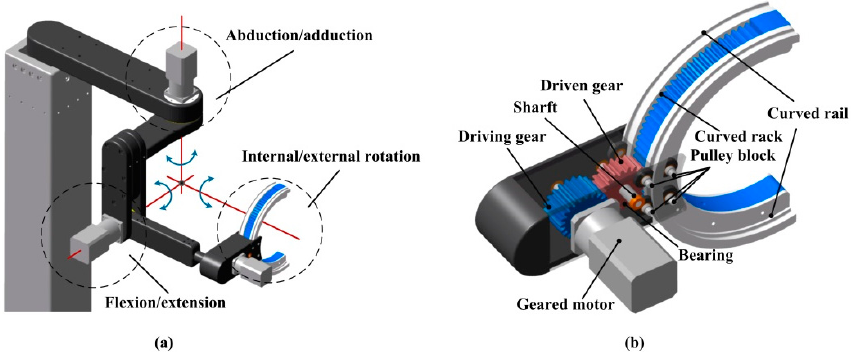
Figure 2. The structure diagram of shoulder joint. ( a ) Three-dimensional (3D) model of shoulder joint; ( b ) 3D model of shoulder joint rotation degree of freedom.